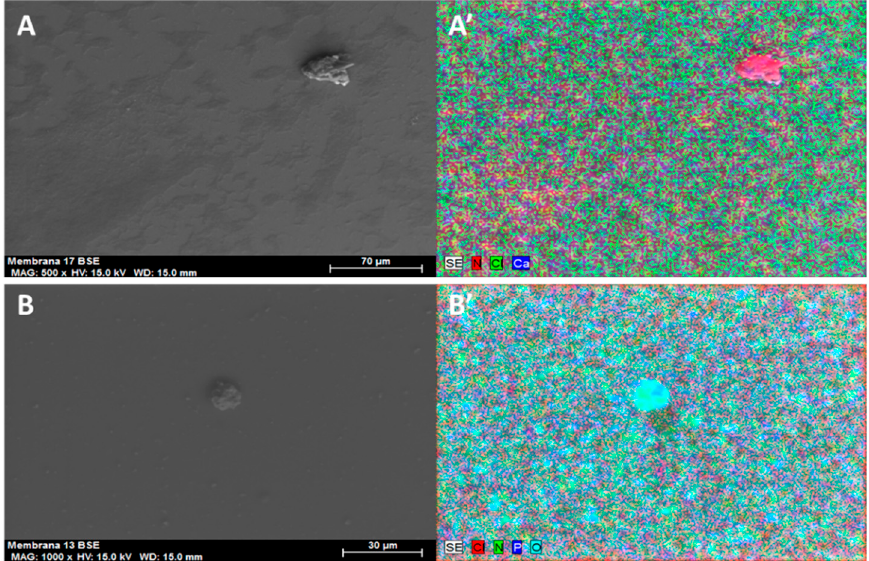
Figure 4. Energy-dispersive X-ray (EDX) analysis of membranes containing 70% w / w ( A ) and 30% w / w of IL ( B ) before being used.